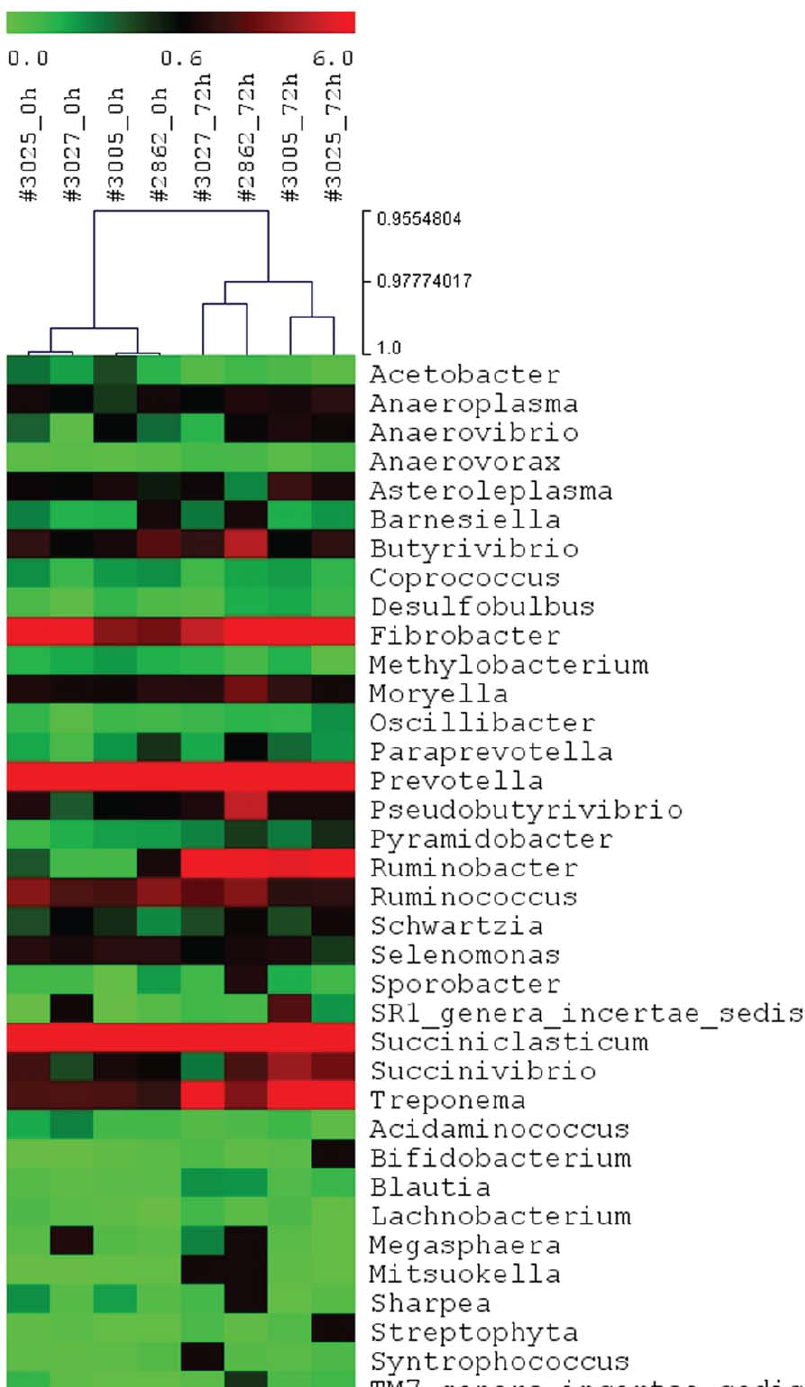
Figure 2. A heat-map of the rumen microbiota composition at a genus level. The 26 genera that shared by all samples tested (core microbiome) were displayed ( N =4). The scale was the percentage composition (log 2) based on the 16S sequences analyzed using RDP Classifier. A 72 h butyrate infusion induced a profound change in the rumen microbial composition, which allowed all 4 samples from this time point to be clustered using a Hierarchical Competitive Learning algorithm (HCL).